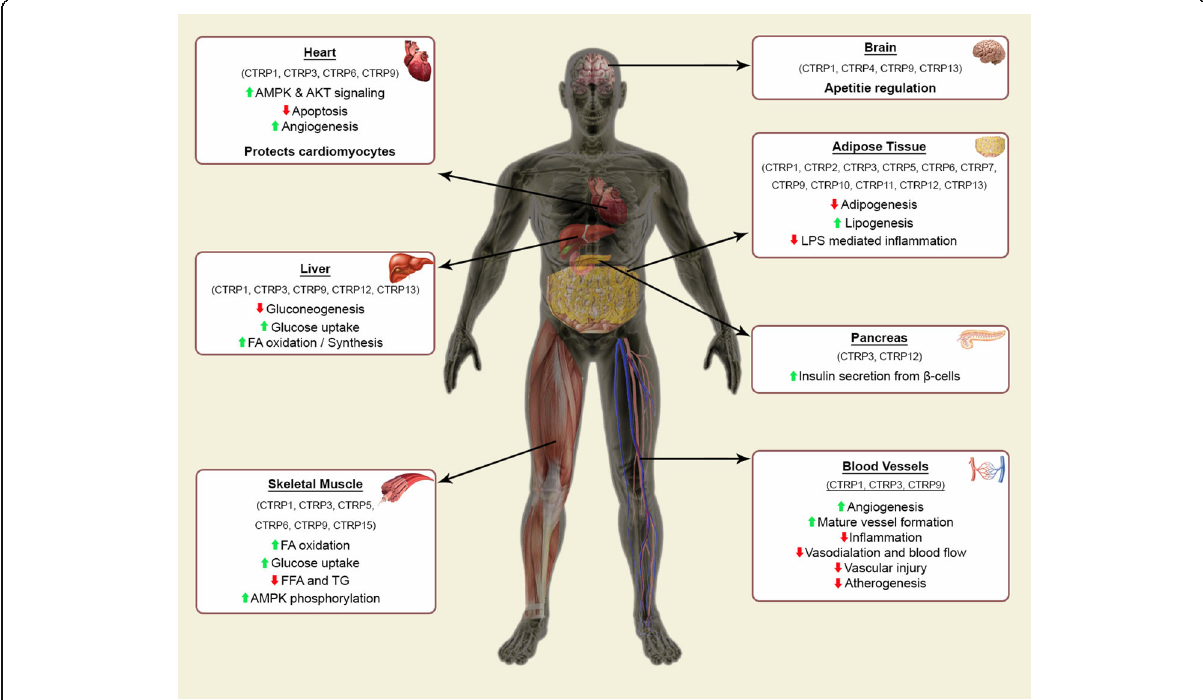
Fig. 2 Expression and functional role of CTRPs in major metabolic tissues and